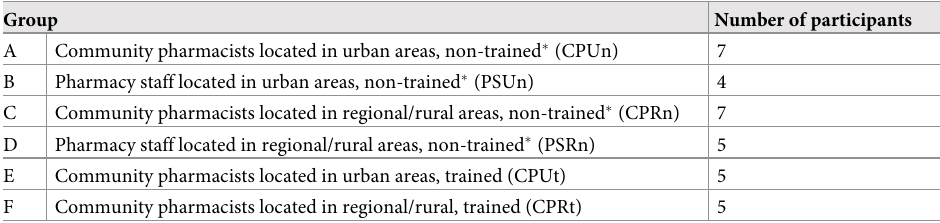
Table 1. Participants in each focus group. Group Number of participants A Community pharmacists located in urban areas, non-trained � (CPUn) 7 B Pharmacy staff located in urban areas, non-trained � (PSUn) 4 C Community pharmacists located in regional/rural areas, non-trained � (CPRn) 7 D Pharmacy staff located in regional/rural areas, non-trained � (PSRn) 5 E Community pharmacists located in urban areas, trained (CPUt) 5 F Community pharmacists located in regional/rural, trained (CPRt) 5 � Community pharmacists and pharmacy staff who were not Mental Health First Aidª (MHFA) certified at the time of the focus